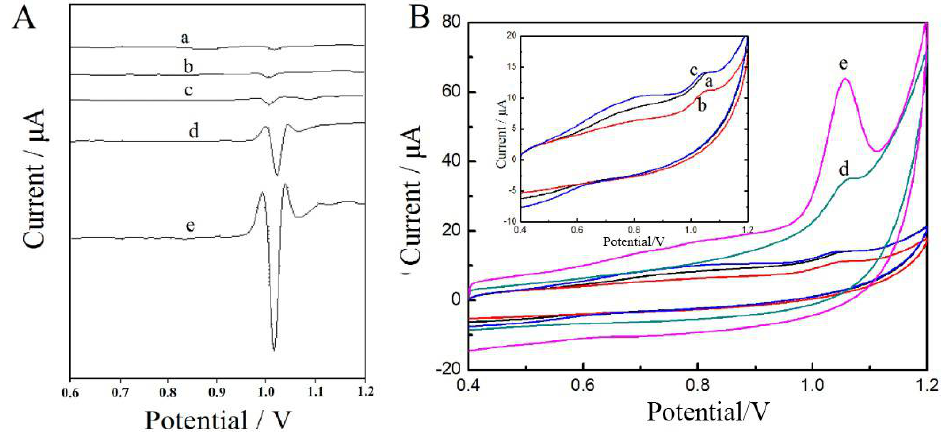
Figure 3. Second-order derivative linear sweep voltammetry (SDLSV) ( A ) and cyclic voltammetry (CV) ( B ) of 1.0 × 10 −5 mol/L tartrazine on different electrodes (a: GCE; b: GO–GCE; c: TiO 2 –GO–GCE; d: ErGO–GCE; e: TiO 2 –ErGO–GCE).